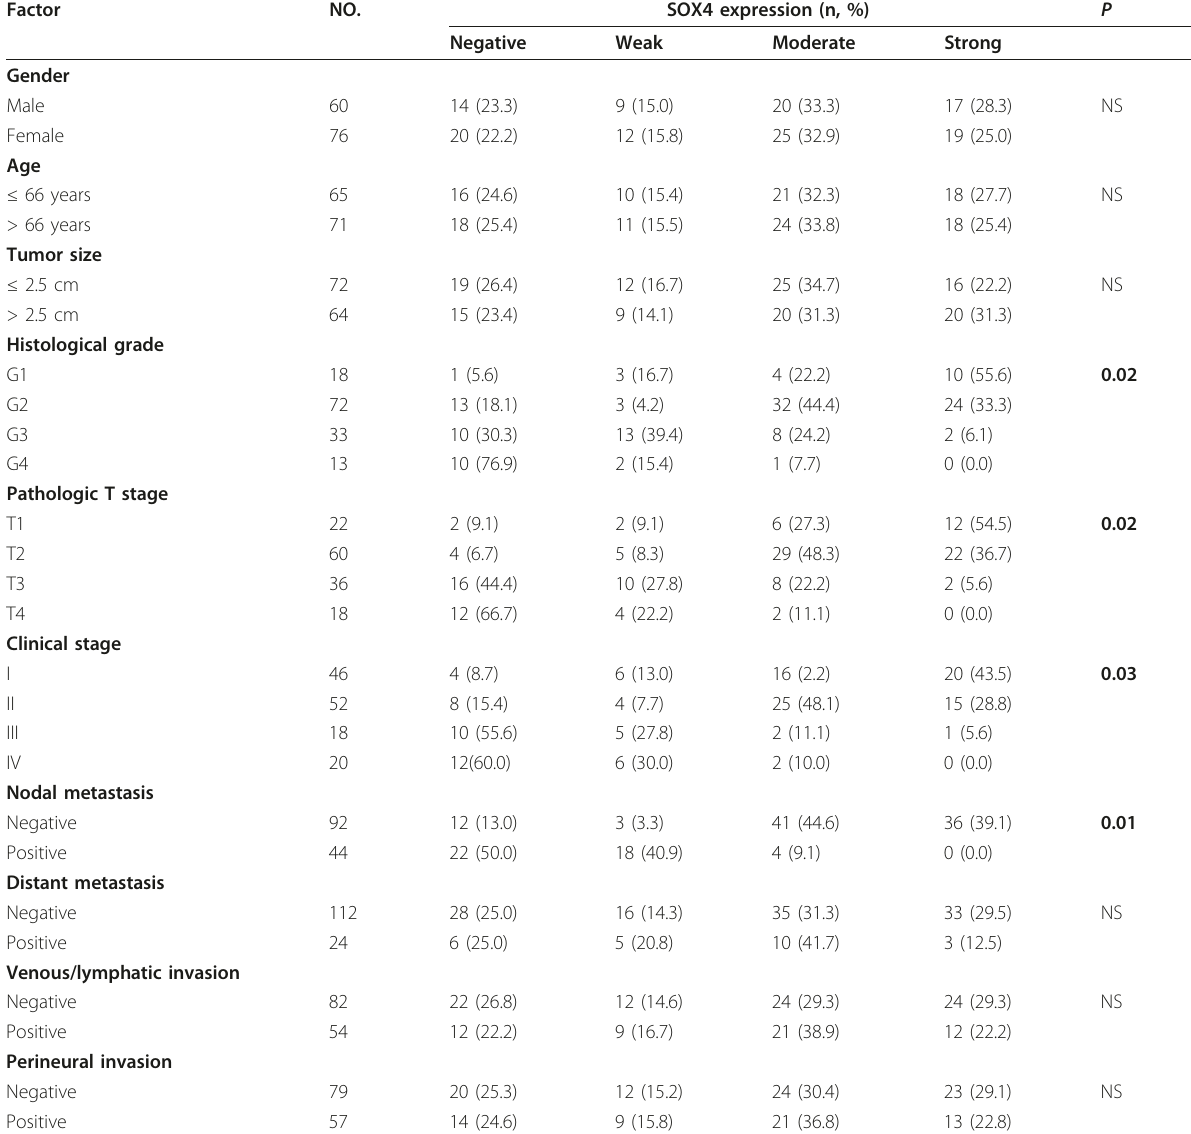
Table 1 Association of SOX4 expression with the clinicopathological features of 136 patients with PGC Factor NO. SOX4 expression (n,